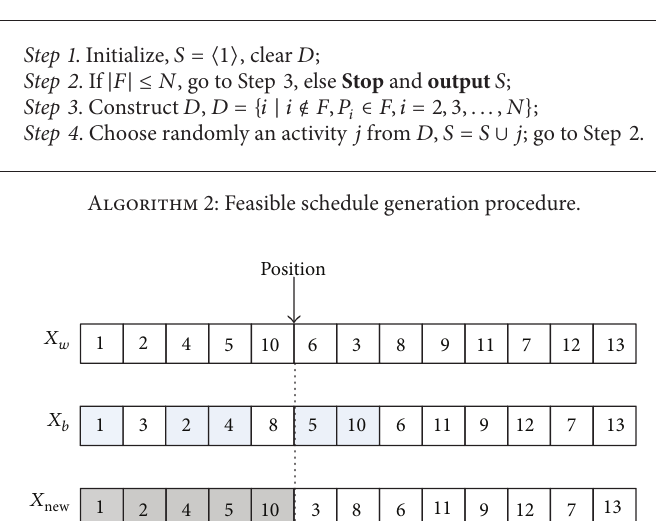
Algorithm 1: Decoding procedure for a feasible schedule 𝑞 .